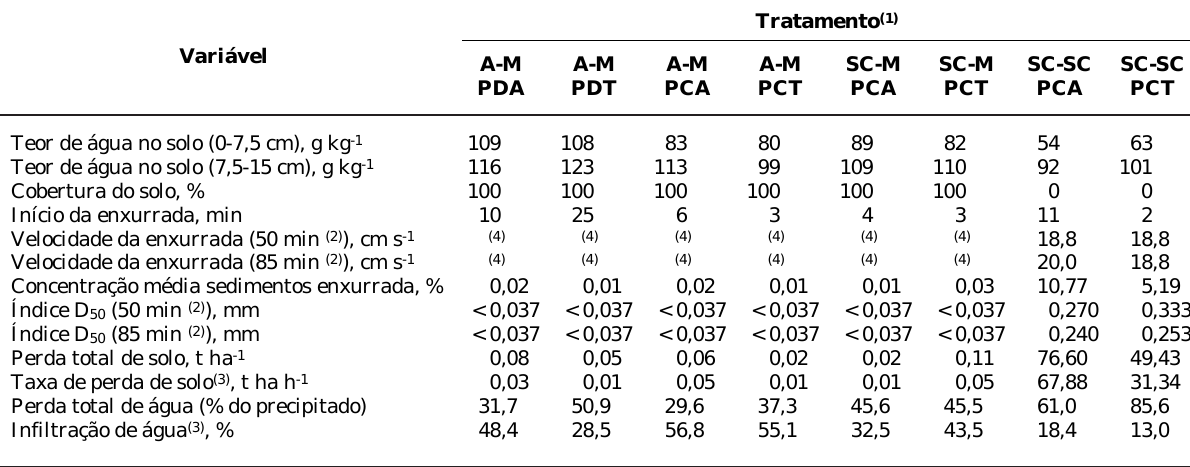
Quadro 5. Valores das variáveis relacionadas com a erosão, obtidos na chuva (intensidade constante de